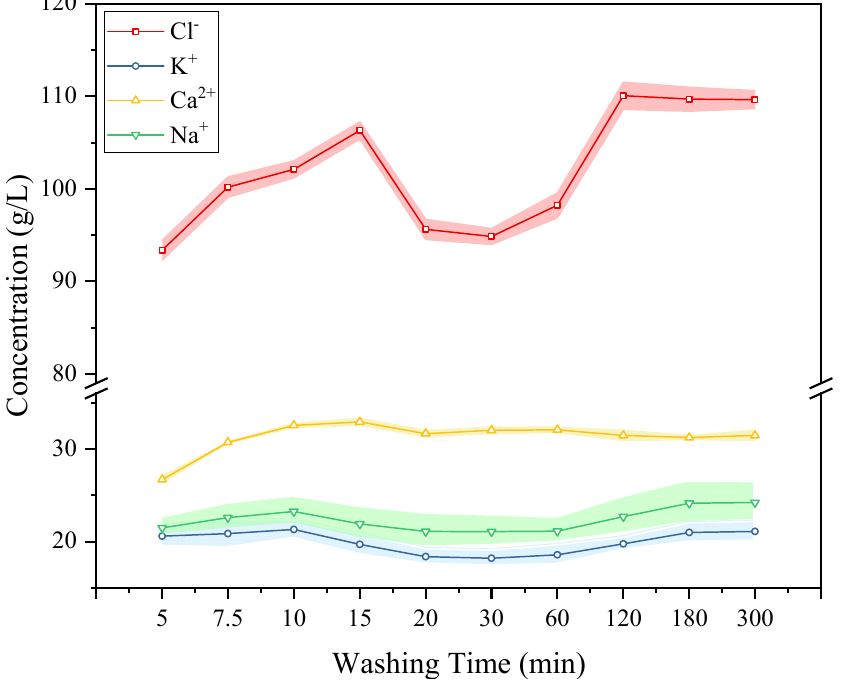
Figure 6. The variation of the main components of simulated WWS.